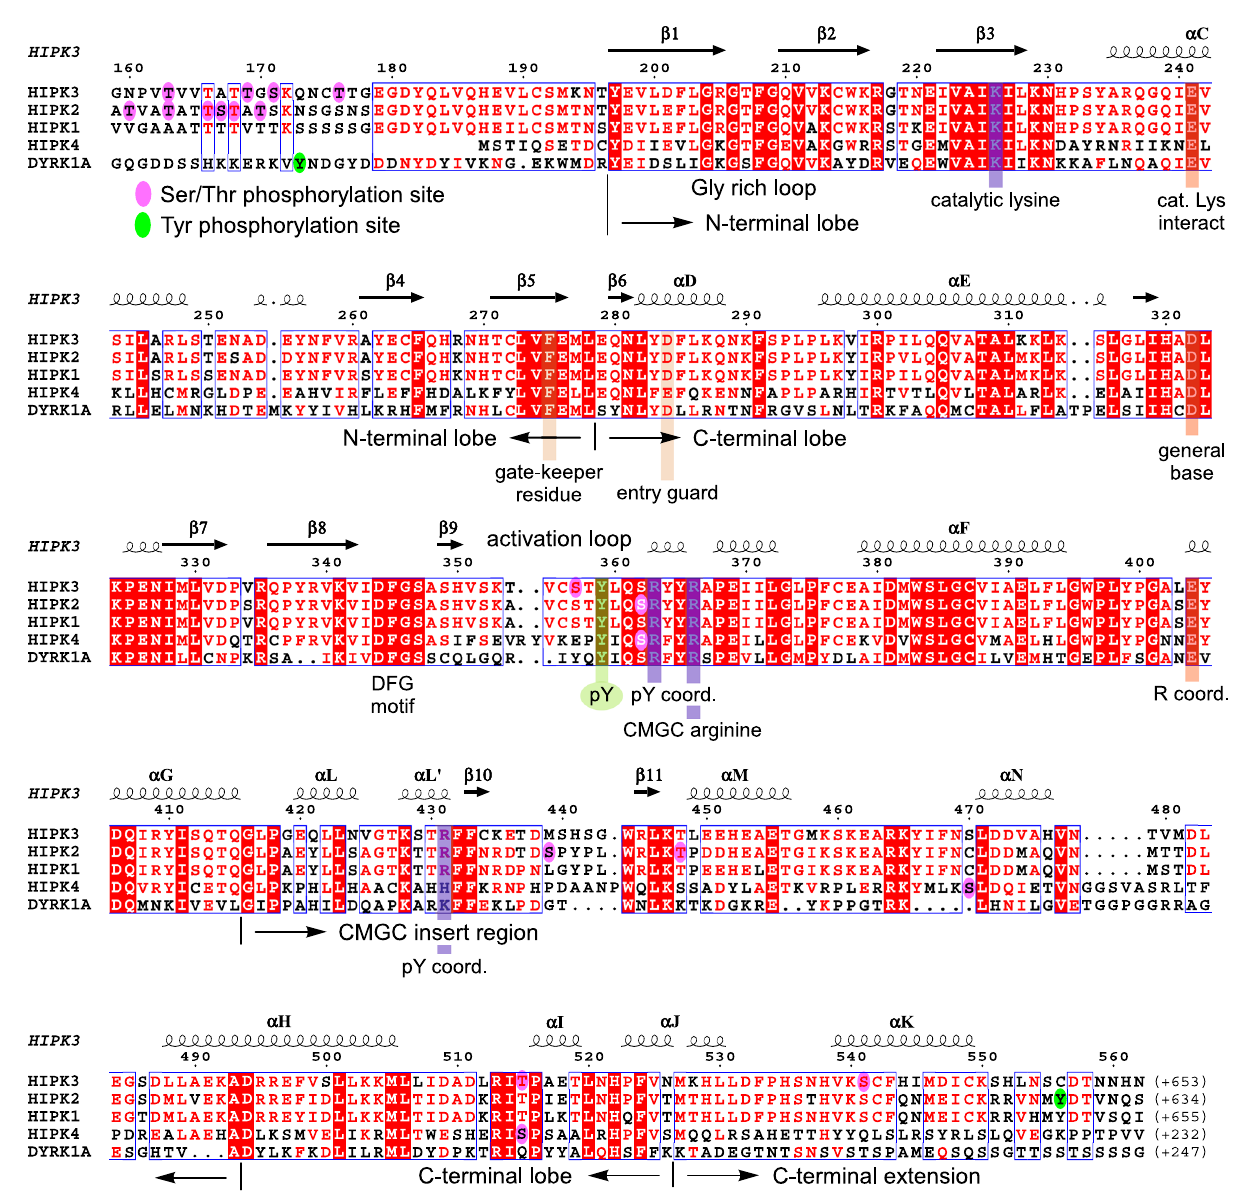
Fig. 2 Sequence alignment of human HIPK1 – 4 and DYRK1A kinase domains. Sequence alignment of the kinase domain of human HIPKs and DYRK1A over the entire length of the crystallized HIPK3 construct (159 – 562). Secondary structure elements are indicated for HIPK3 as determined for the apo- HIPK3 structure. Characteristic sequence motifs, including the phosphorylated T-loop tyrosine, and functional regions are indicated. Serine/threonine or tyrosine residues found to be phosphorylated are circled magenta or green, respectively. Residues conserved in all kinases are boxed red, and those that are similar have red characters. The sequence alignment was prepared with MultAlin. The secondary structure alignment was prepared with